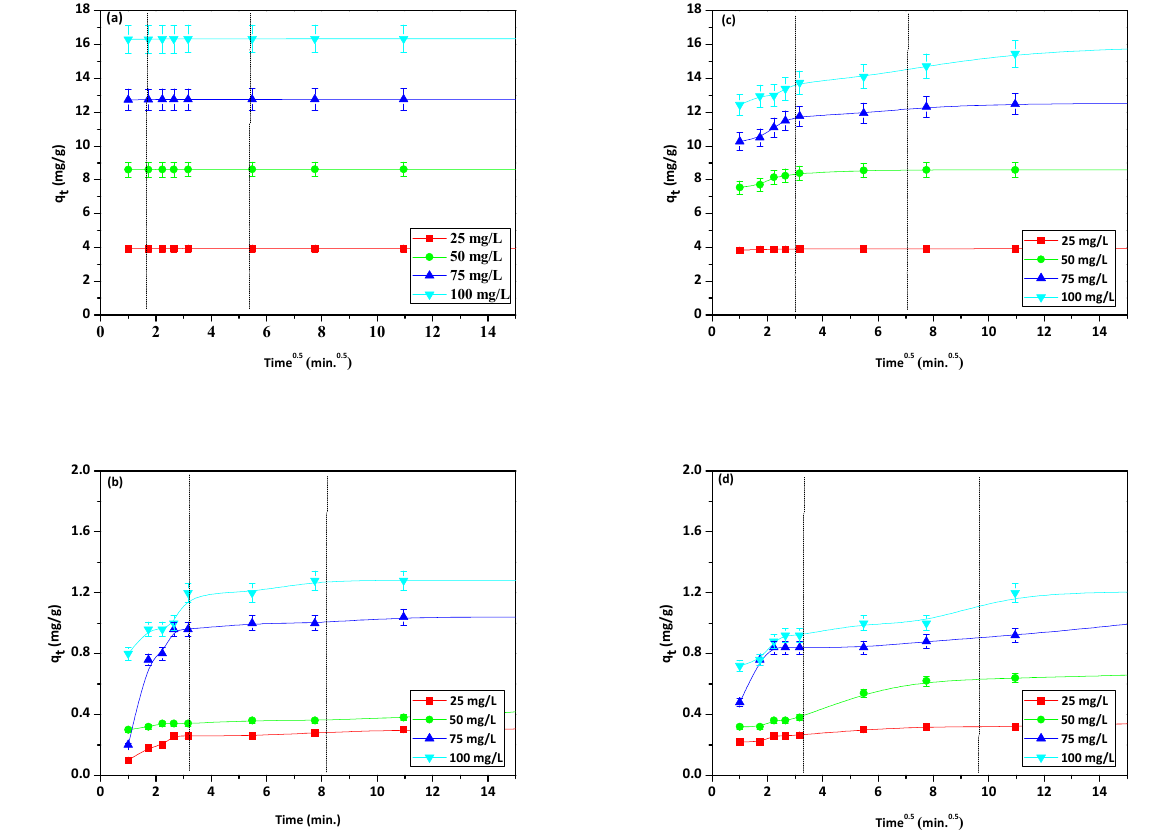
Figure 10. Kinetic plots of intraparticle diffusion model for sorption of ( a ) Cu(II), ( b ) phenol on NaP1, ( c ) Cu(II), and ( d ) phenol on NaP1CS ( C 0 = 25, 50, 75, 100 mg/L of Cu(II) and phenol, m = 0.1 g, t = 120 min).